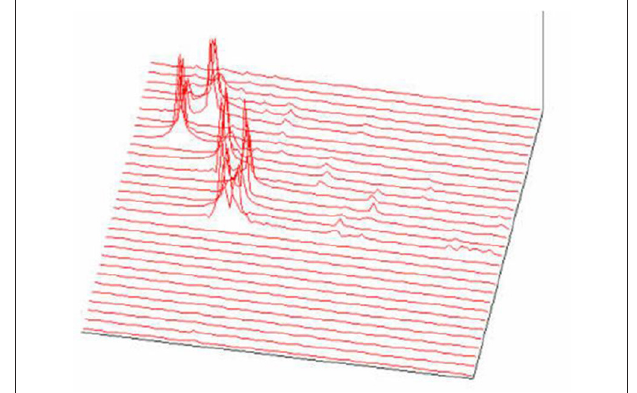
FIGURE 21 | FFT spectrogram as a part of the acoustic melody recognition (Jovanovi´c, 2001; Jovanovi´c et al.,